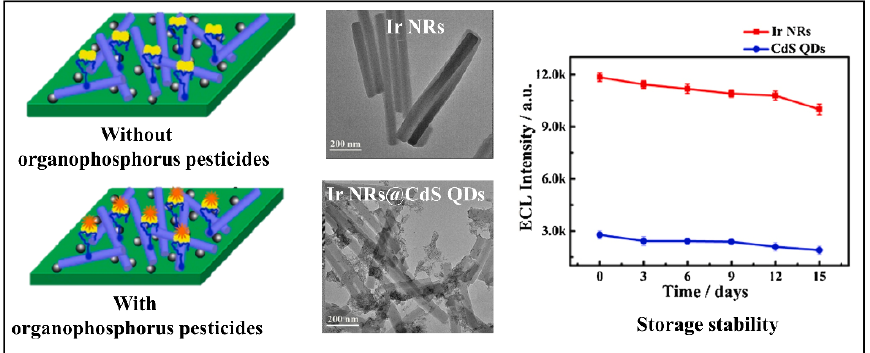
Figure 8. The schematic description of the actuation of the biosensor in OPs presence and TEM im- ages of Ir NRs, and Ir NRs@CdS QDs. Reproduced with permission from Yang et al. [76]. Copyright 2021,